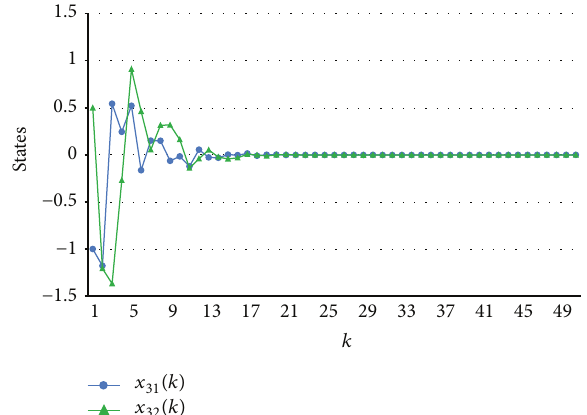
Figure 3: States respond of subsystem 3, 𝑥 31 (𝑘) and 𝑥 32 (𝑘) under discrete-time integral